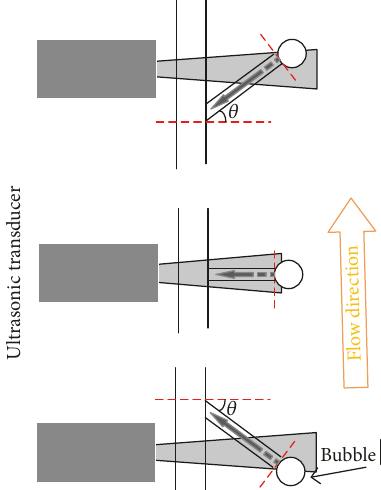
Figure 3: Different refraction angles in different